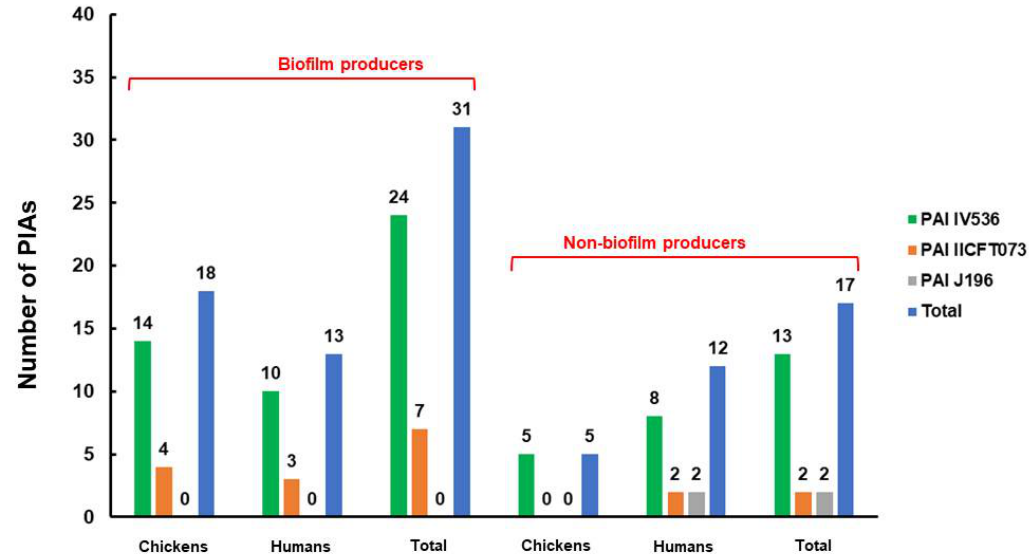
Figure 4. Distribution of pathogenicity islands (PAIs) among E. coli isolates in relation to biofilm